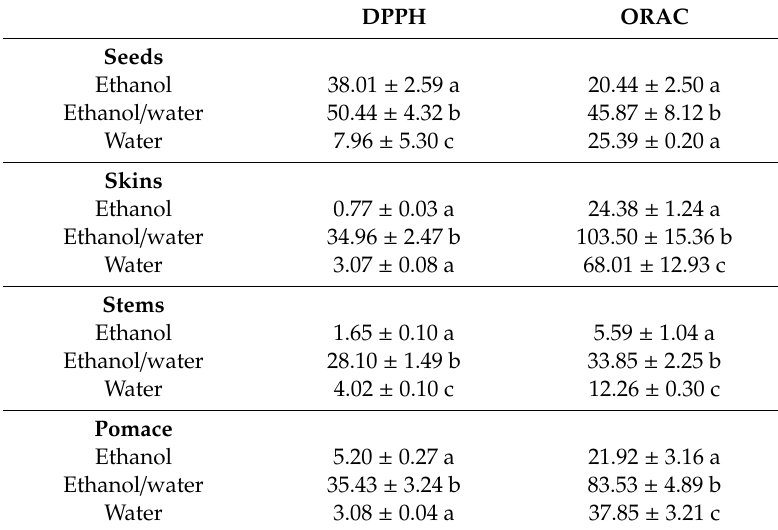
Table 2. Antioxidant activity (mmol TE / 100 g) measured by 2,2-diphenyl-1-picrylhydrazyl (DPPH) and Oxygen Radical Absorbance Capacity (ORAC) assays in seeds, skins, stems and pomace extracts obtained with di ff erent solvents (ethanol, ethanol / water and water).